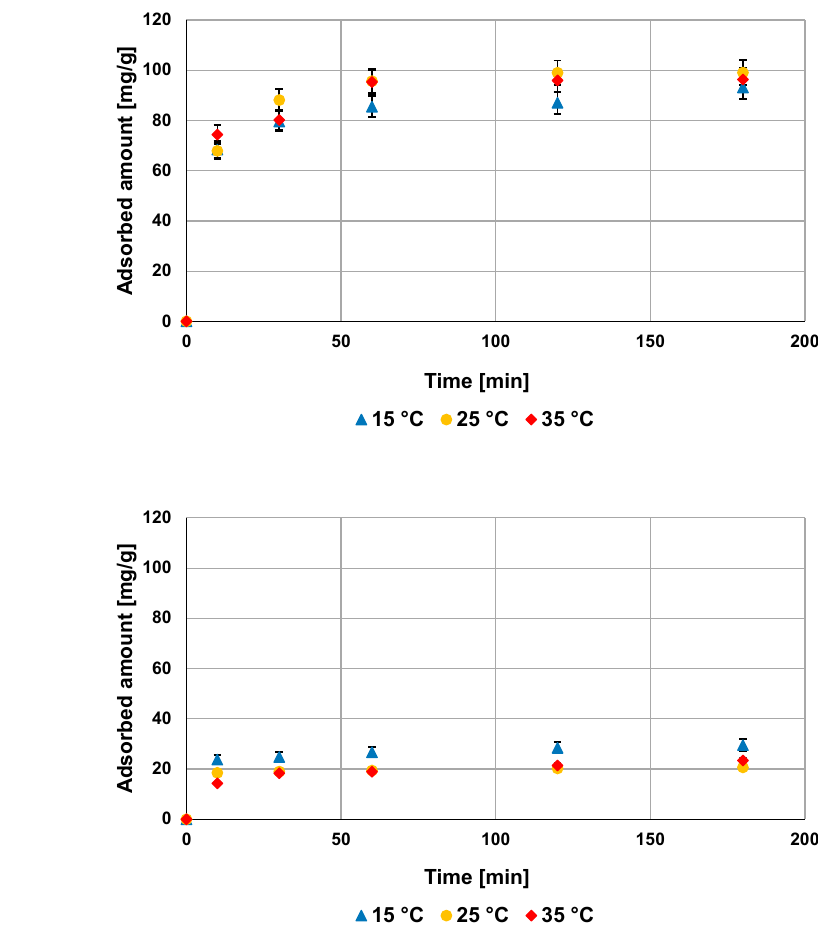
Figure 6. Adsorption kinetics of PAA ( a ) and PEI ( b ) on NE–AC activated carbon surface at three examined temperatures, pH 3. Table 3. Kinetic parameters of the PAA/PEI adsorption on the NE–AC activated carbon. Calculated Parameters